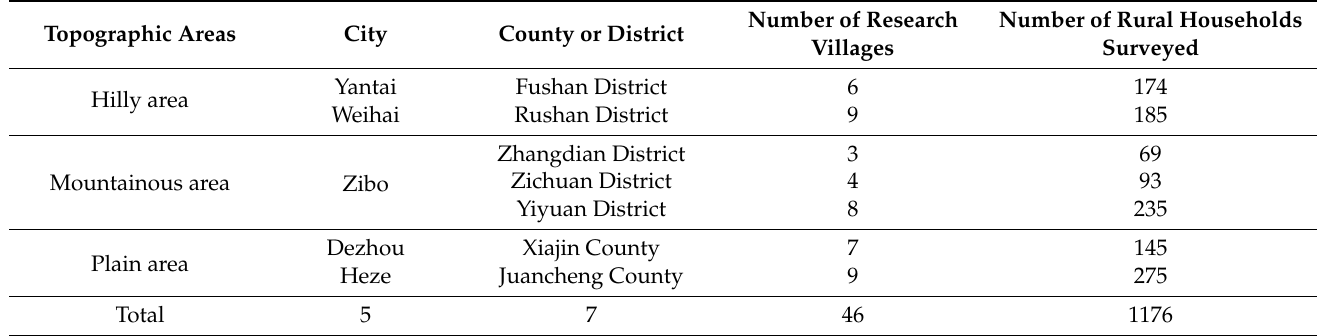
Table 1. Statistics of the surveyed